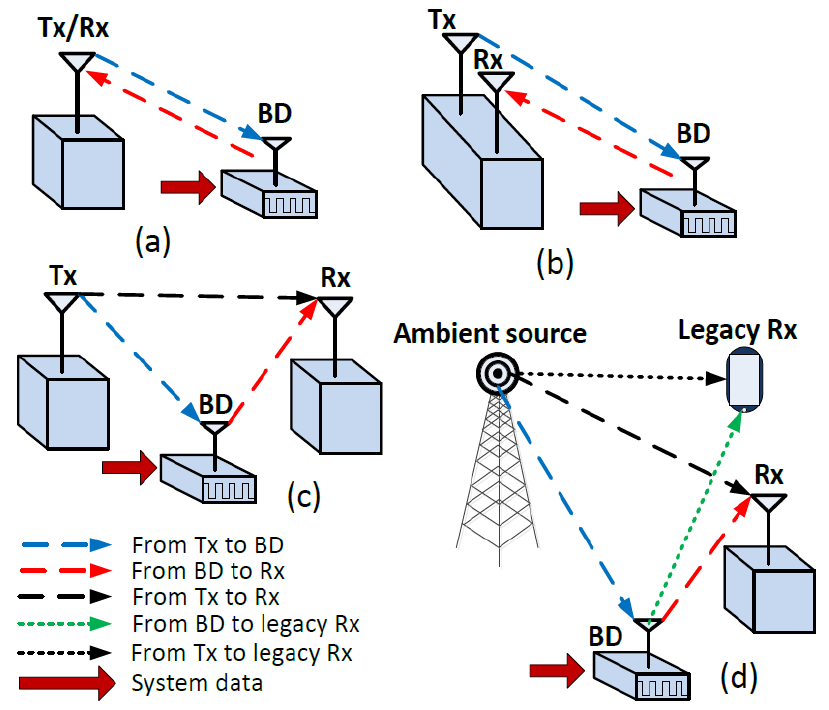
Figure 1. Traditional and ambient backscatter configurations, ( a ) monostatic, ( b ) bi-static co-located, ( c ) bi-static dislocated, and ( d )